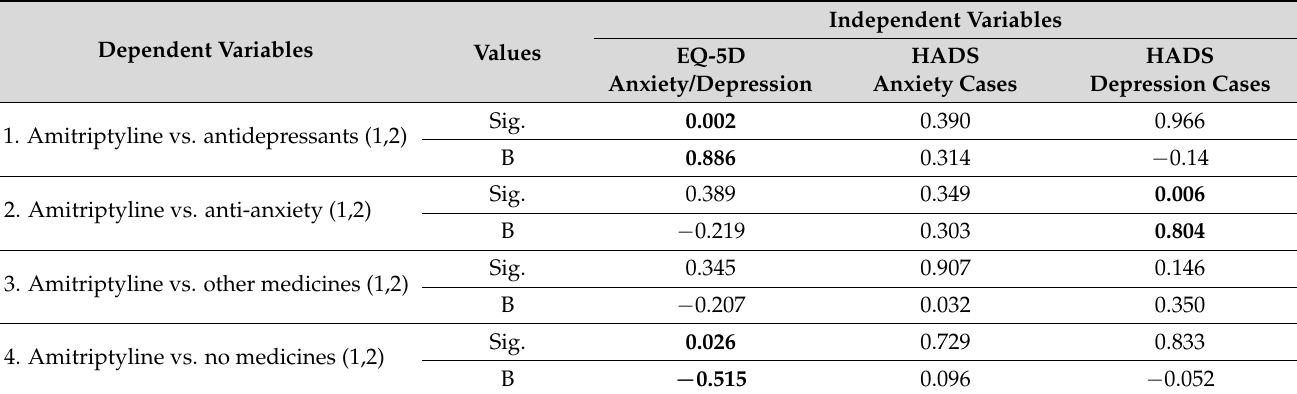
Table 8. Logistic regression analysis